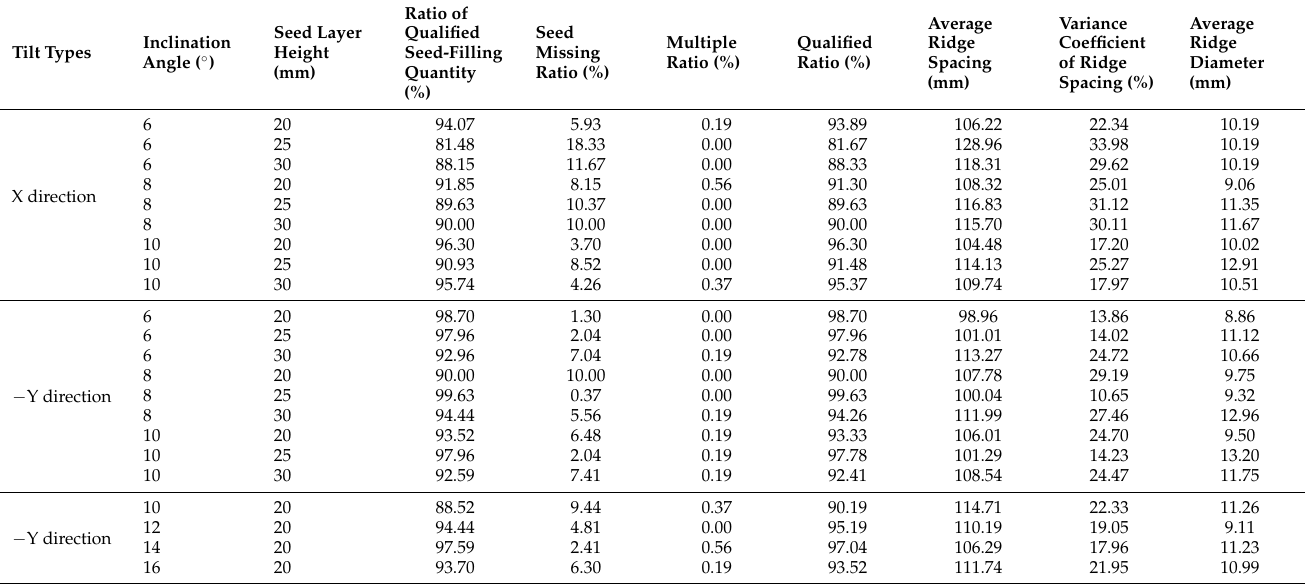
Table 5. Seeding performance under seed-cleaning treatment in − Y and X inclination directions.